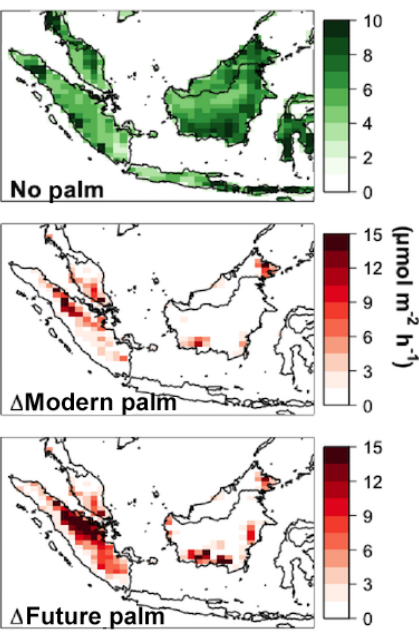
Figure 4. Annual mean simulated isoprene emissions over SEA (top) and the change due to Modern (middle) and Future (bot- tom) oil palm expansion.